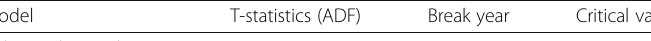
Table 4 Gregory – Hansen cointegration test with structural break